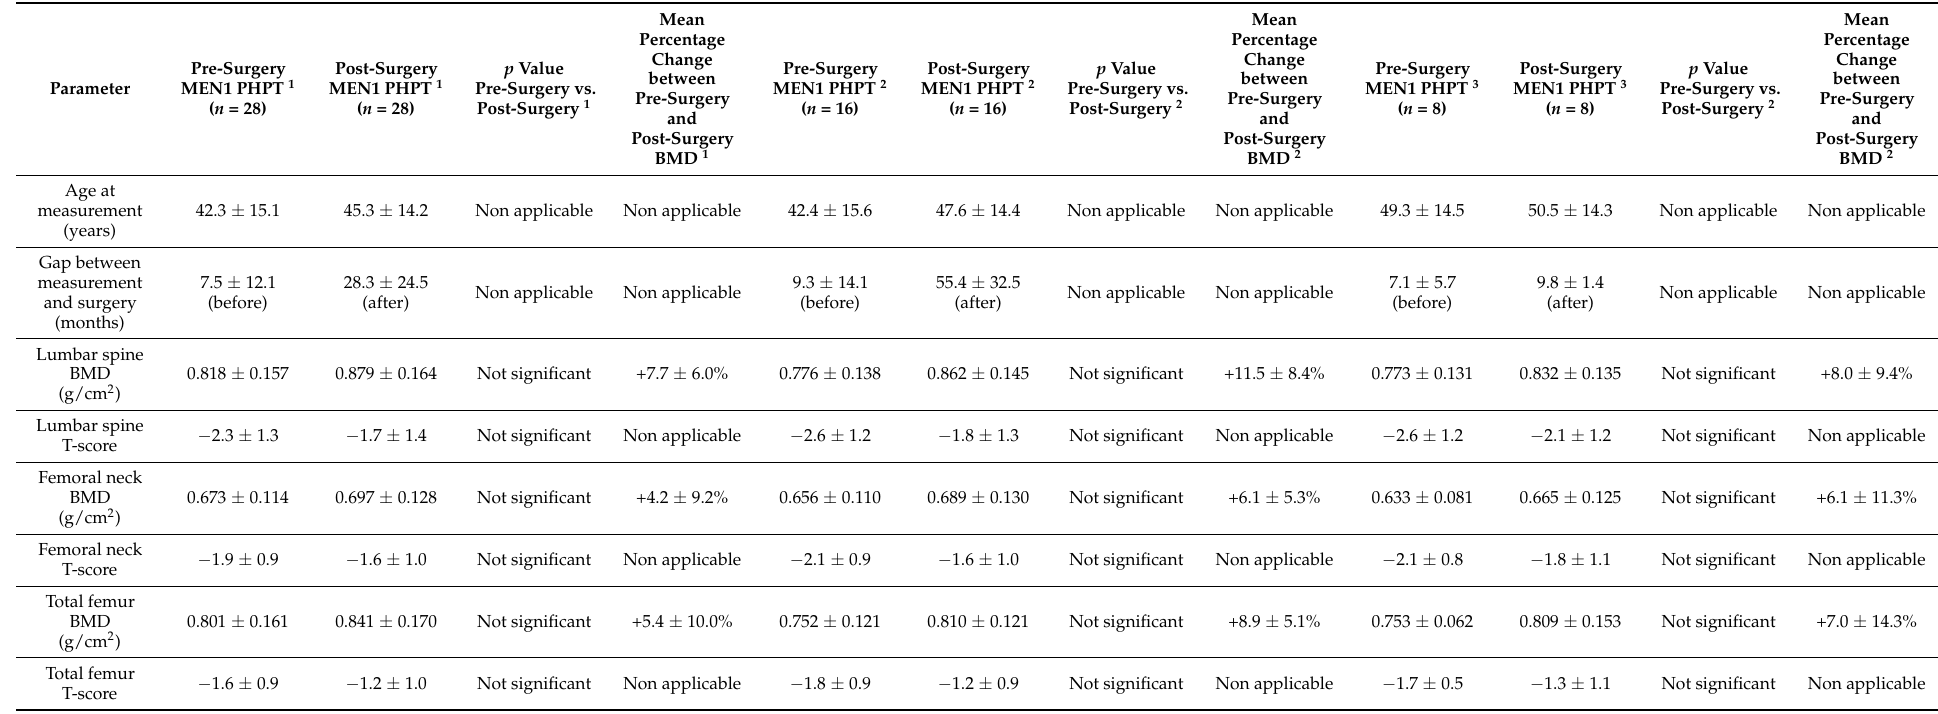
Table 5. Comparison of DXA parameters, measured before and after PTX, in MEN1